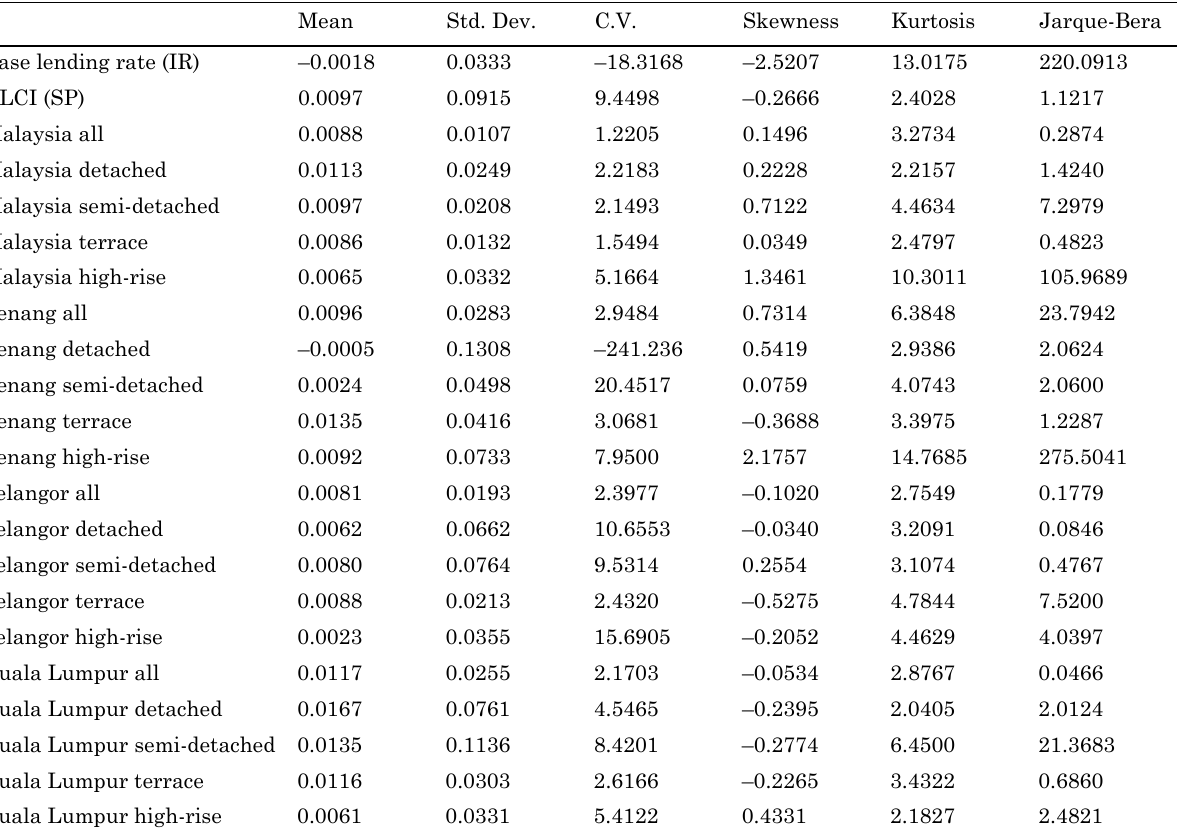
Table 1. Descriptive statistics of price